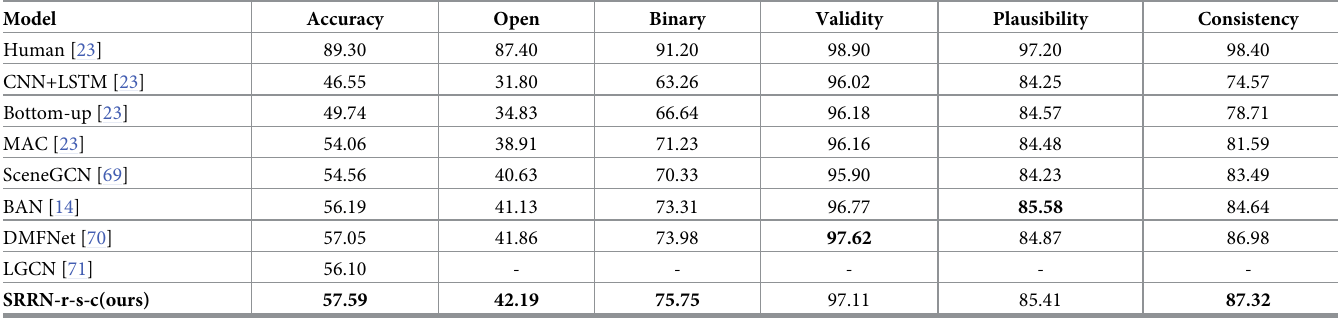
Table 5. Performance comparison results on GQA dataset.